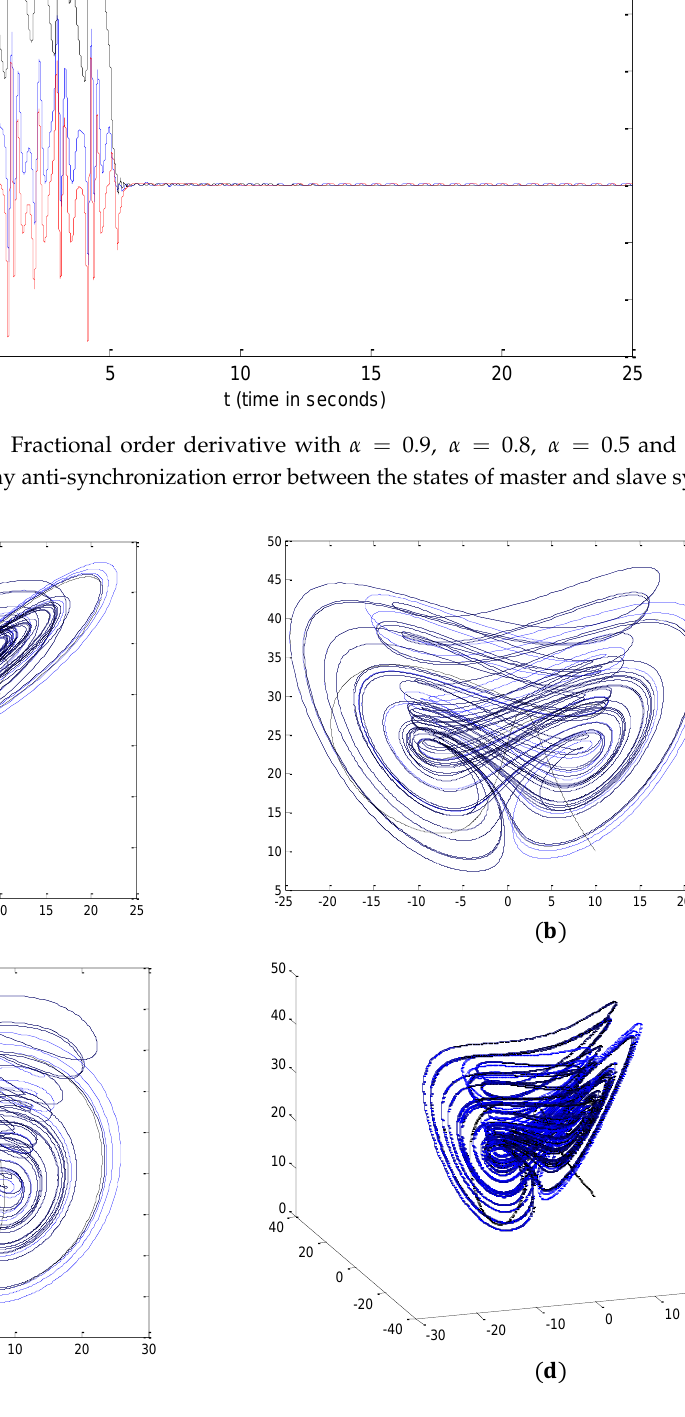
Figure 5. The phase portraits for the synchronization between Chen (Black Line) and time-delay Lorenz chaotic systems (Blue Line) with 𝛼 = 0.9 and time delay 𝜏 = 5 s: ( a ) On (𝑥 − 𝑦,𝑥 1 − 𝑥 2 ) phase plane; ( b ) on (𝑥 − 𝑧,𝑥 1 − 𝑥 3 ) phase plane; ( c ) on (𝑦 − 𝑧,𝑥 2 − 𝑥 3 ) phase plane; ( d ) on (𝑥 − 𝑦 − 𝑧,𝑥 1 − 𝑥 2 − 𝑥 3 ) space.